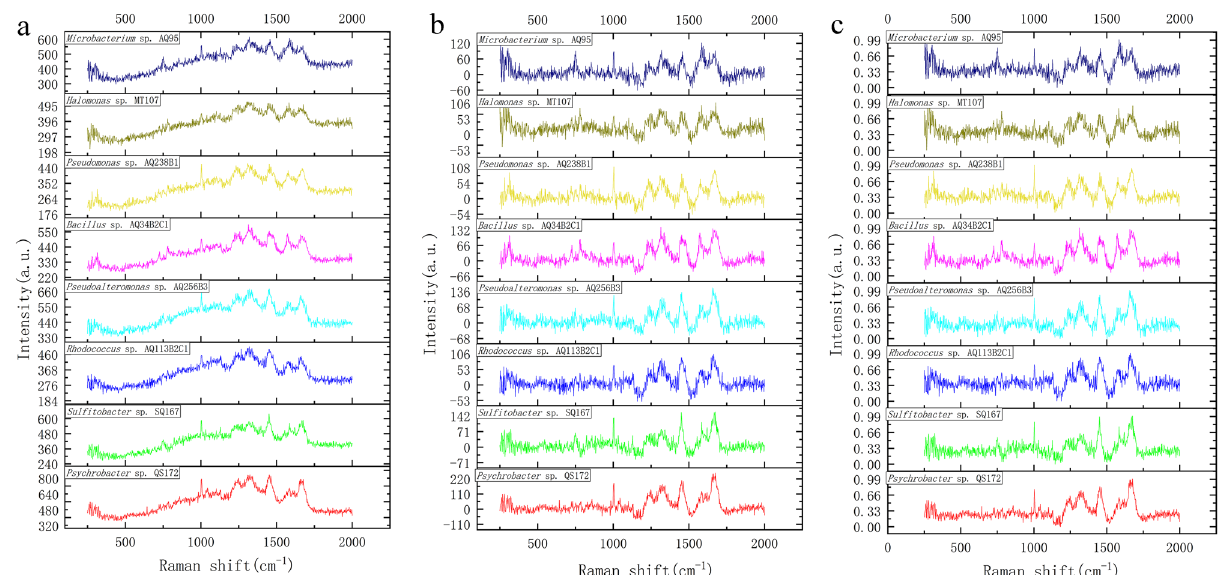
Figure 2. Examples of raw and preprocessed spectra examples. (a) Untreated spectra of 8 bacteria. ( b ) Spectra after baseline subtraction. ( c ) Spectra after normalization. These spectra are input into our